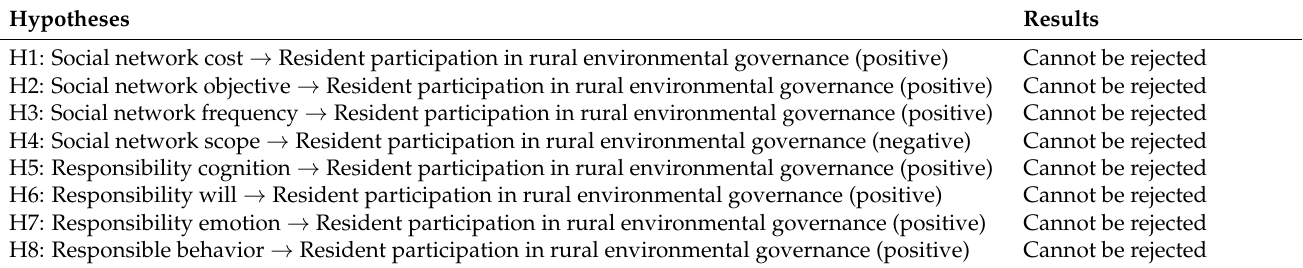
Table 6. Results of hypotheses